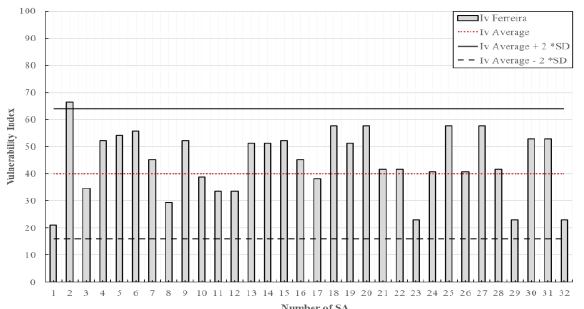
Figure 8. Results of the application of Ferreira